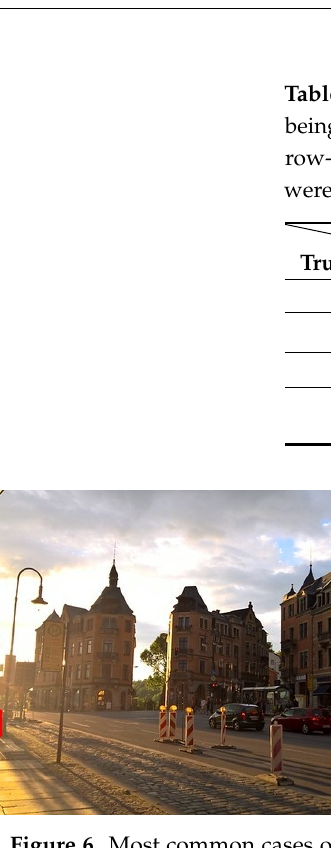
Figure 6. Most common cases of false negatives, i.e., unidentified bicycles, from left to right: small size or unfavorable lighting conditions, partial occlusions, unusual pose of bicycle or camera.